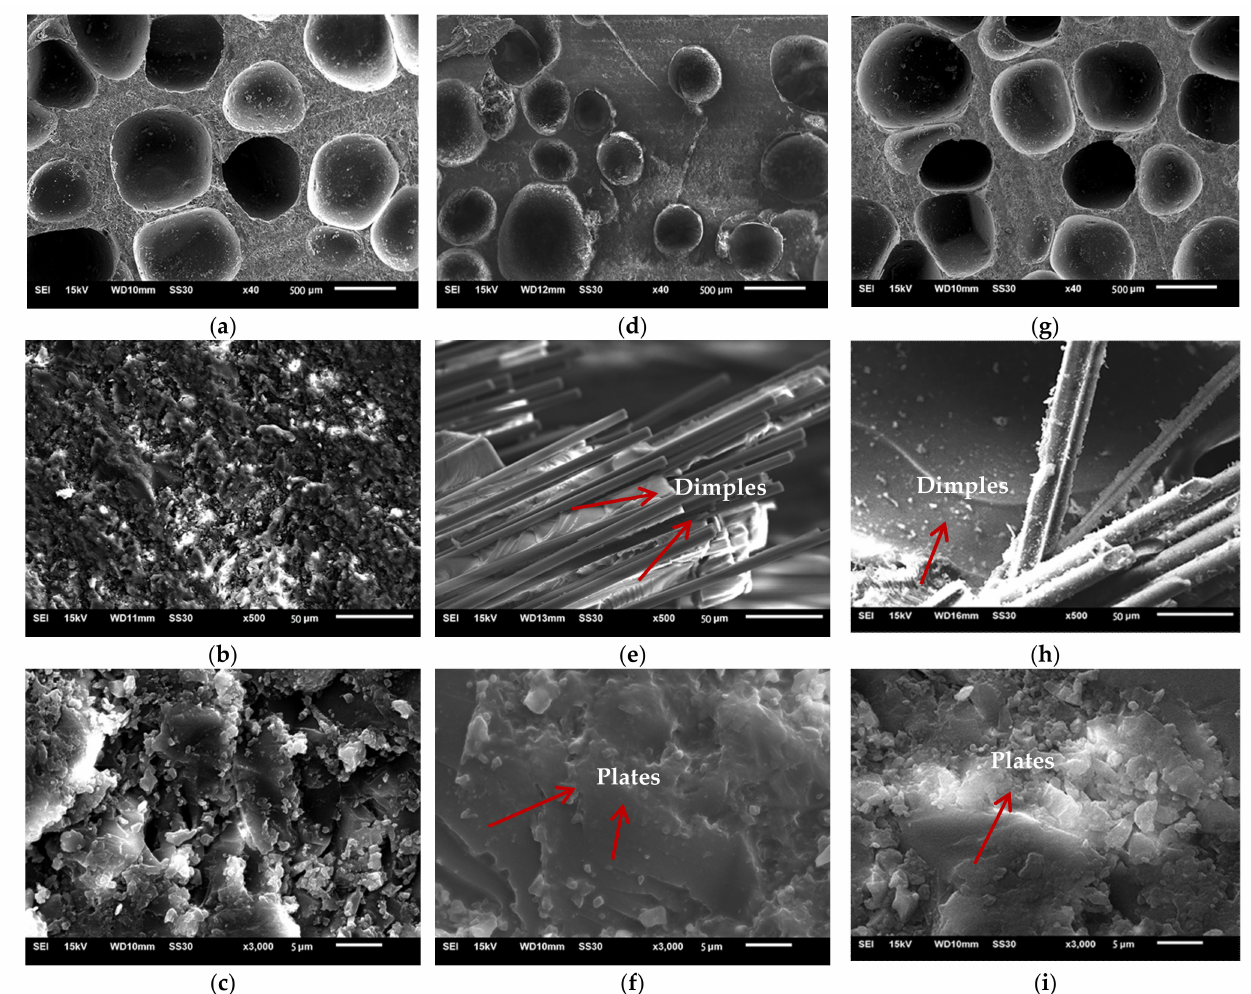
Figure 7. Scanning electron microscope micrographs of cured low-density unsaturated polyester resin sample ( a – c ), cured CCFR-LDUPR sample in presence of 4.00 phr chopped carbon fibers ( d – f ), and cured CGFR-LDUPR sample in the presence of 4.00 phr CGFs ( g – i